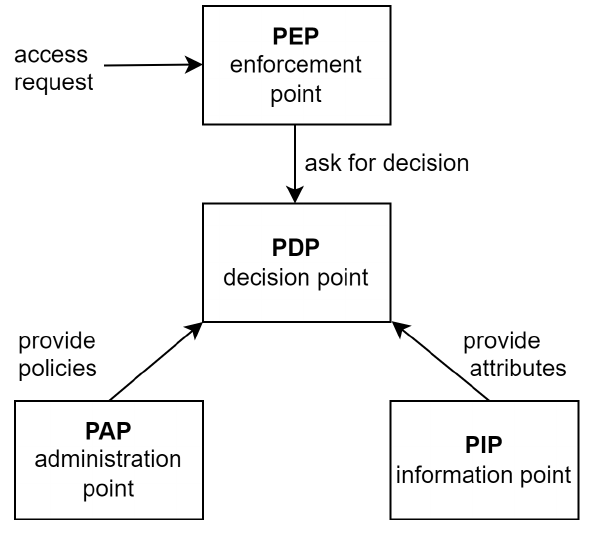
Figure 2. XACML Architecture